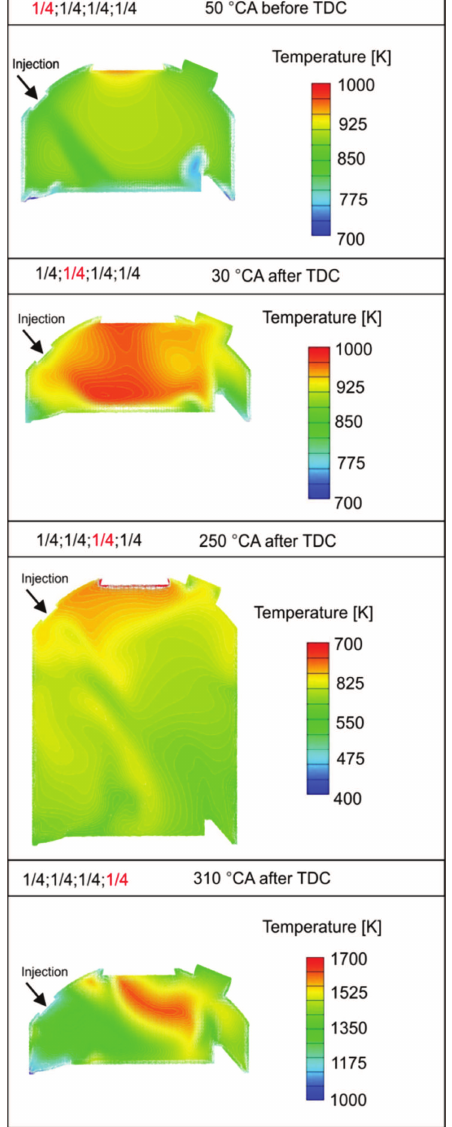
Fig. 5. Thermal stratification in the cylinder at different angles of injection